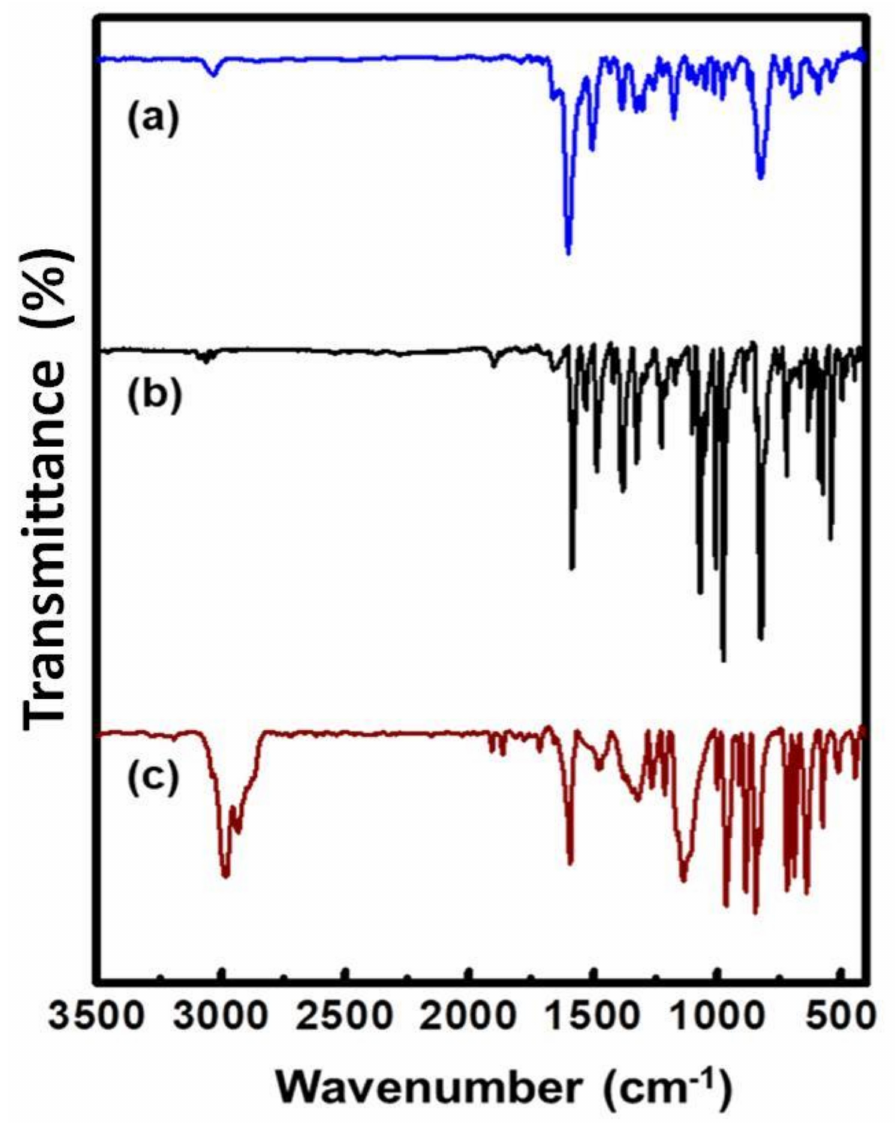
Figure 1. FTIR spectra of ( a ) CPP-P2, ( b ) 2,3-bis(4-bromophenyl)pyrido(3,4-b)pyrazine, and ( c ) benzene-1,3,5-triboronic